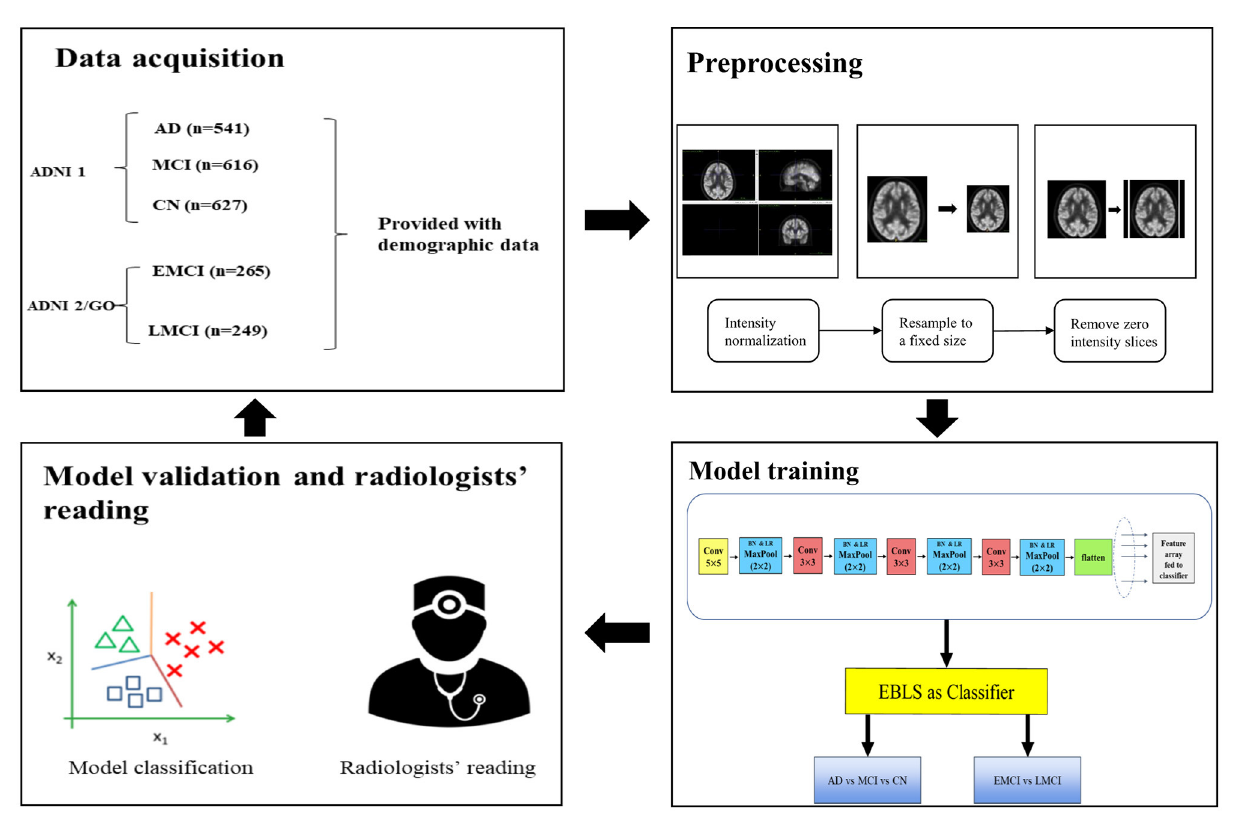
FIGURE3 Main steps of the experiment. The data set was split into training and test sets at a ratio of 8:2. In the validation step, the radiologists were provided with demographic information to aid their readings.